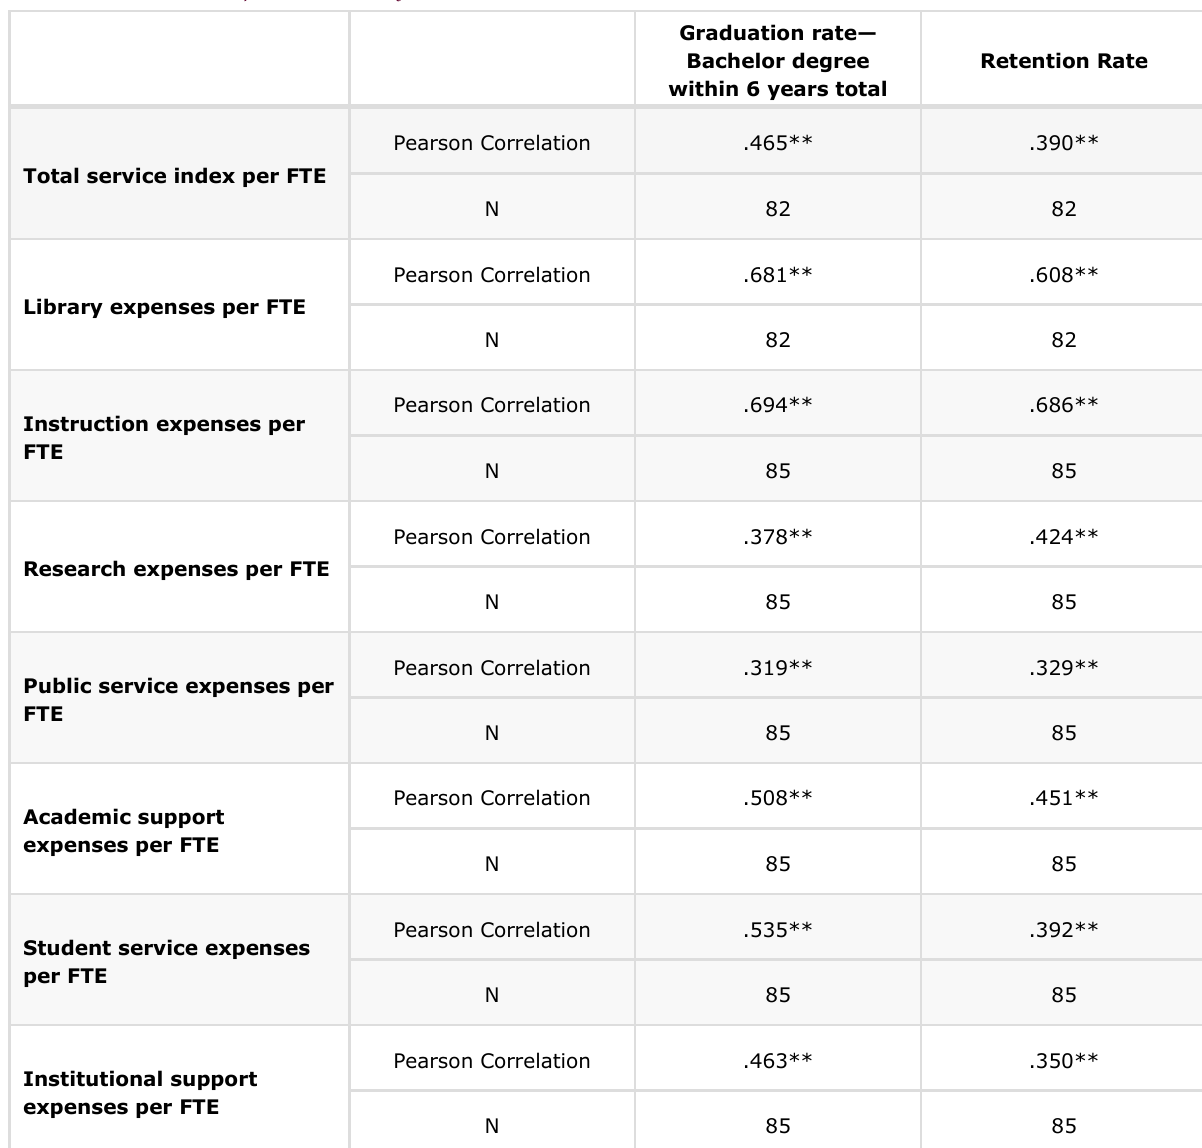
Correlations between Expense and Library Variables and Graduation and Retention